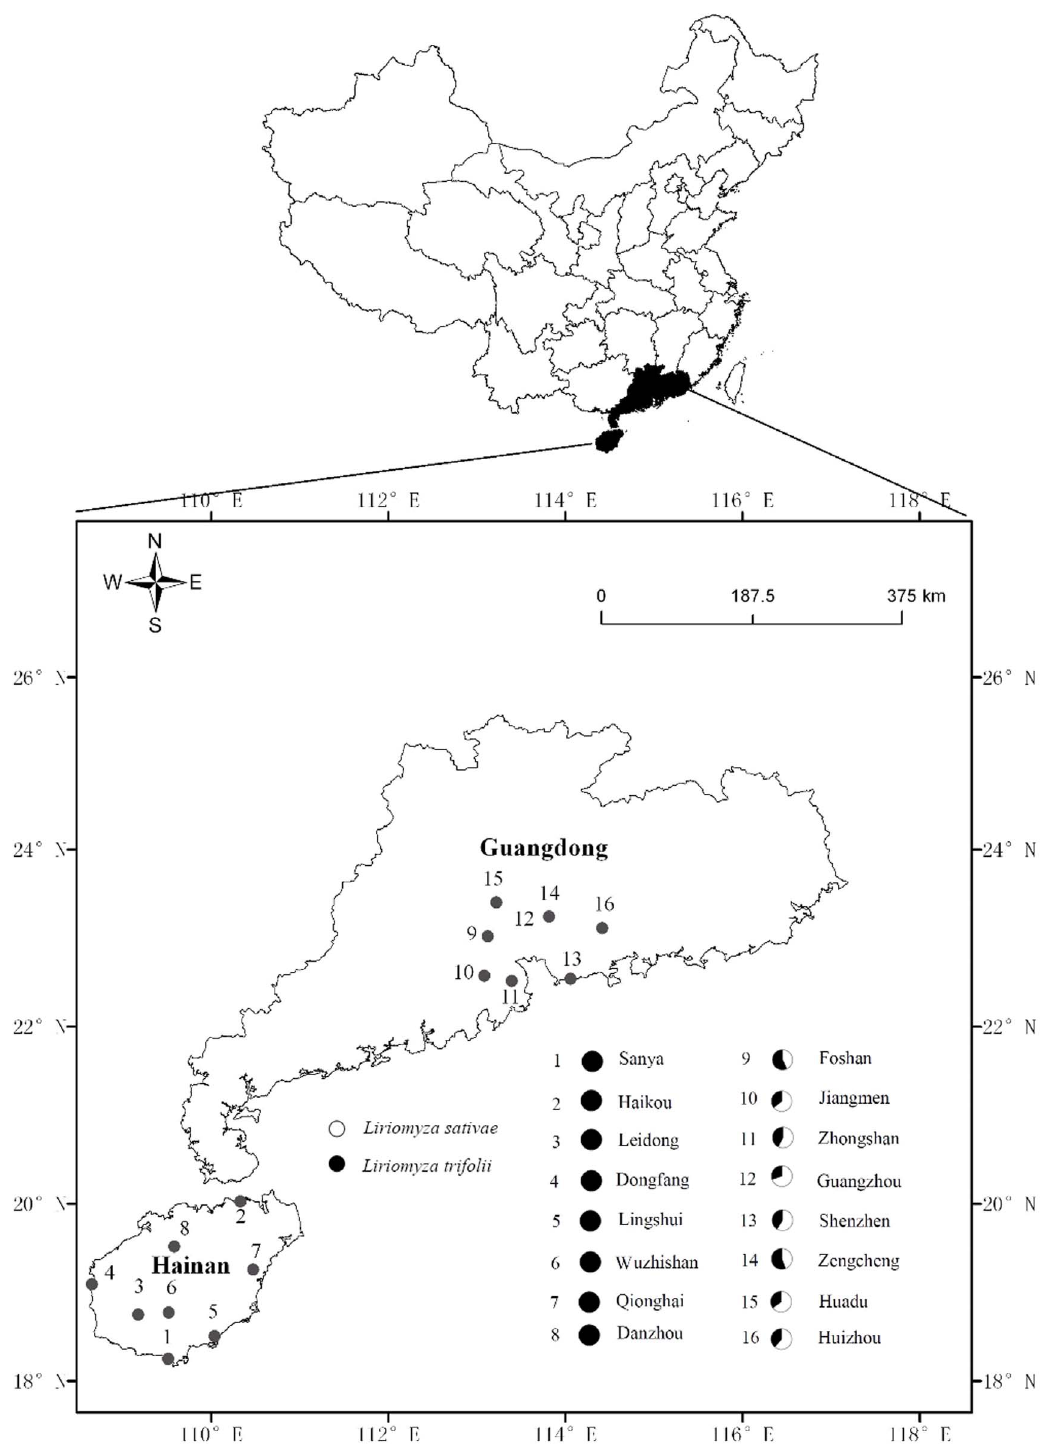
Figure 3. Map showing field sites in Hainan Province and Guangdong Province where cowpeas ( Vignauniguilata ) were surveyed for Liriomyza species during 2011.